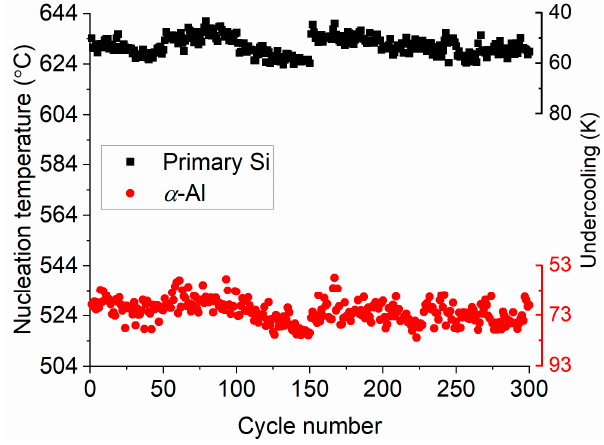
Figure 4. Nucleation temperatures and undercoolings of primary Si and α -Al dendrites as measured from 300 cycles.